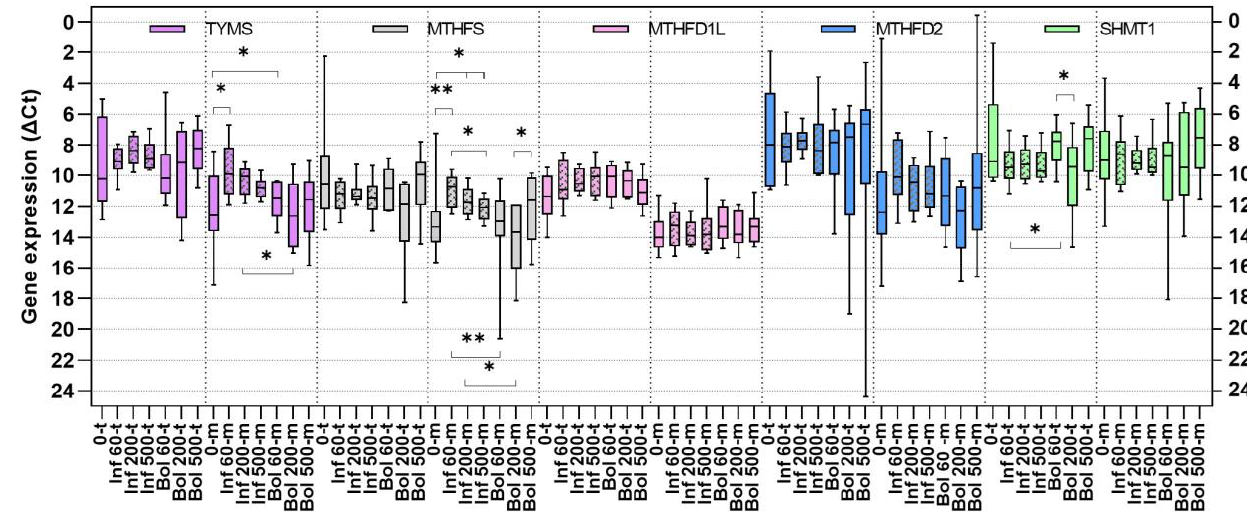
Figure 4. Box plots showing median gene expression levels in tumors (t) and mucosa (m) of colon cancer patients at baseline (0, n = 10) and after administration of 60 mg/m 2 (Inf n = 10, Bol n = 10), 200 mg/m 2 (Inf n = 10, Bol n = 8), or 500 mg/m 2 (Inf n = 10, Bol n = 10) LV administered as two-hour infusion (Inf, shaded boxes) or bolus (Bol) injections. Significance asterisks above boxes show differences in tumors or mucosa related to LV dosage whereas significance asterisks below boxes show differences in tumors or mucosa relating to LV administration (two-hour infusion or bolus injection) at a specific LV dosage. * p 0.05; ** p 0.01, *** p 0.001.